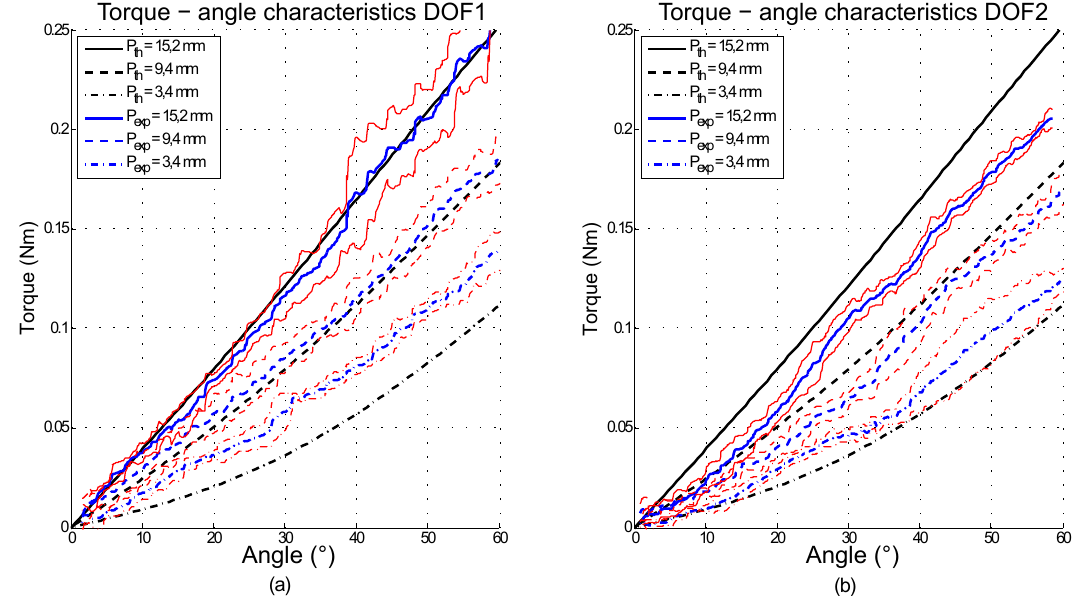
Figure 11. The experimentally measured torque-angle ( α ) characteristics of DOF1 ( a ) and DOF 2 ( b ) compared with the theoretically calculated ones for three different pre-tensions. Red curves are the measurement deviations from the average measured blue